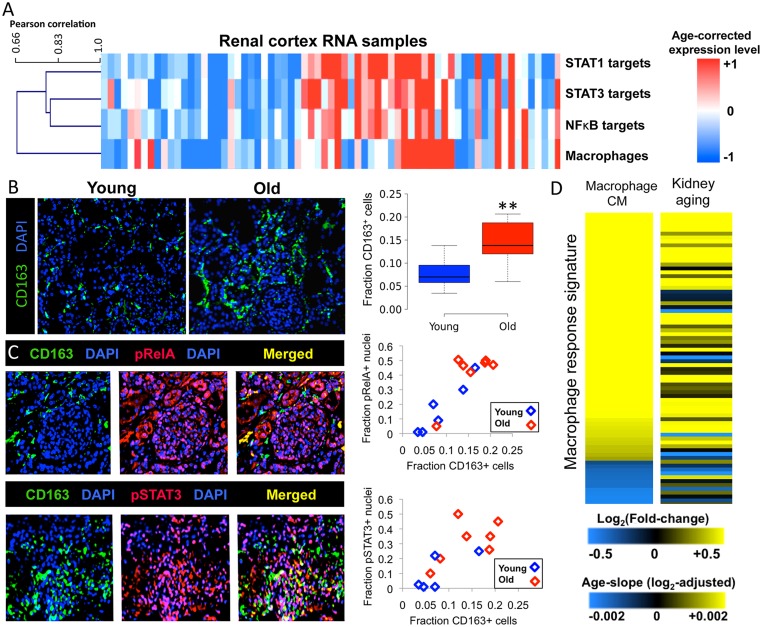
Correlations of the activities of STAT1, STAT3, NFκB and macrophage abundance in individual kidneys.A. In this heat map the rows indicate estimated macrophage abundance based on macrophage-specific transcript expression, or level of activation of each transcription factor, based on the averaged expression of transcription factor direct target genes (see Methods). The colors indicate relative levels of macrophage abundance or transcription factor target gene expression compared to other individuals of that age; red columns represent individuals with higher expression of macrophage-specific transcripts or transcription factor target genes for their age (older than expected at the gene expression level), and blue columns represent individuals with lower expression levels of macrophage markers of transcription factor target genes for their age (more youthful at the gene expression level). The columns are clustered such that individuals with values that are high or low for their age appear together. B. Macrophage infiltration in the kidney increases with age: images of renal cortex samples showing CD163 staining (green) with DAPI counterstaining (blue). Shown is a representative example of a young renal cortex (left) and an old renal cortex (right). The boxplot quantifies macrophage infiltration. The relative abundance of macrophages was defined as the fraction of CD163+ cells/all DAPI+ cells The boxes indicate 25th and 75th percentiles for the group, and the lines indicate maximum, median and minimum values. **P < 0.01 (Student’s t test, one-sided). C. Macrophage abundance correlates with levels of activation of STAT3 and NFκB in individual kidneys. Human renal cortex stained with anti-CD163 antibodies (macrophage marker), co-stained with either pRelA (top panels) or pSTAT3 antibodies (bottom panels). Right scatterplots show the correlation between overall macrophage abundance and pSTAT3 nuclear immunoreactivity (top) or pRelA nuclear immunoreactivity (bottom) in epithelial compartments of individual renal cortex tissues. Red diamonds represent old individuals (ages 66–85 years) and blue diamonds represent young individuals (ages 25–44 years). The x-axis indicates the fraction of cells that are CD163+ and the y-axis indicates for the fraction of cells stained positive for pRelA or pSTAT3. D. Macrophage-conditioned media responsive genes are induced during kidney aging. The left column of the heat map shows 77 differentially regulated genes in response to macrophage-conditioned medium (S7 Table) from two microarray studies in different human cell lines [38,39]. The right column of the heat map shows the changes in gene expression for these genes during kidney aging (age-related slope).